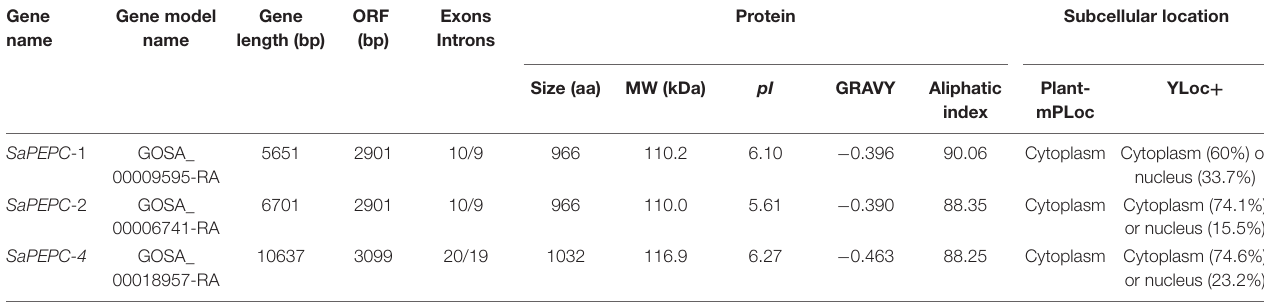
TABLE 1 | Characteristics of PEPC gene family in S. aralocaspica